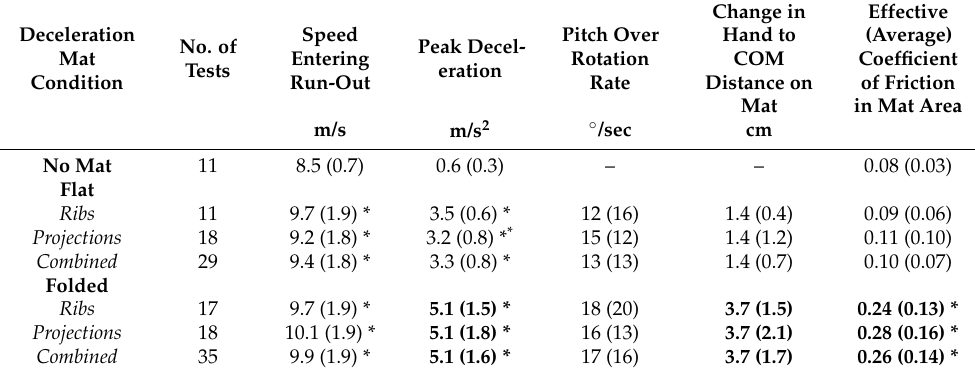
Table 1. Mean kinematic data (standard deviation) from the snow tube interactions with the deceler- ation mats during testing. The effective coefficient of friction is based on the average deceleration across the deceleration mats. The kinematic data are presented for the resultant of the components along the snow surface. There were no statistically significant differences between ribs and projections conditions; the combined rows include all of the ribs and projections conditions for a particular mat geometry. Bold values indicate a statistically significant difference between flat and folded conditions ( p < 0.05). (*) indicates a statistically significant difference compared to the no mat condition ( p < 0.05). Deceleration